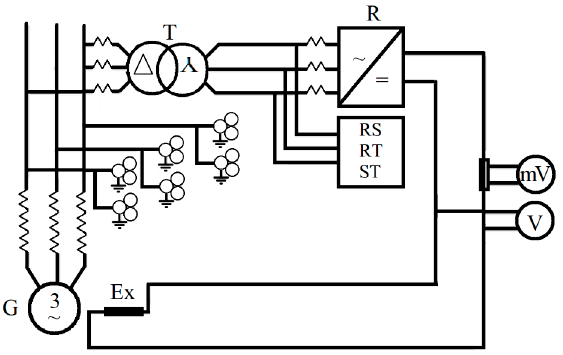
Figure 2. Schematic of a power group with static excitation: G—main generator; T—transformer for the supplying excitation 24/0.65 kV; R—rectifier with controlled thyristors; Ex—excitation winding.